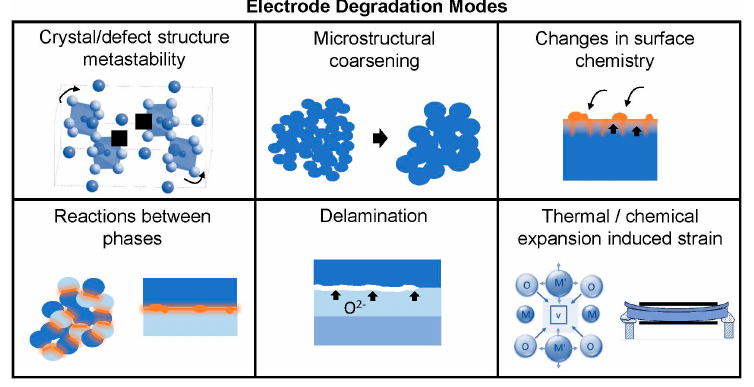
Figure 2. Illustration of degradation modes in oxygen electrode of SOFC/SOEC.